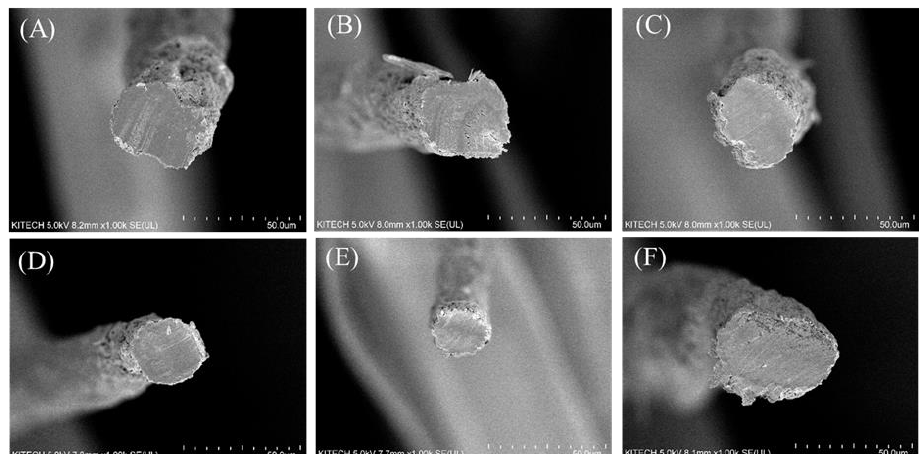
Figure 6. Cross section of porcine/tilapia conjugated collagen fibers. ( A ) Porcine collagen 100% fiber, ( B ) porcine collagen 80% fiber, ( C ) porcine collagen 60% fiber, ( D ) porcine collagen 40% fiber, ( E ) porcine collagen 20% fiber, and ( F ) tilapia collagen 100% fiber. The scale of all figures is 50.0 µ m.